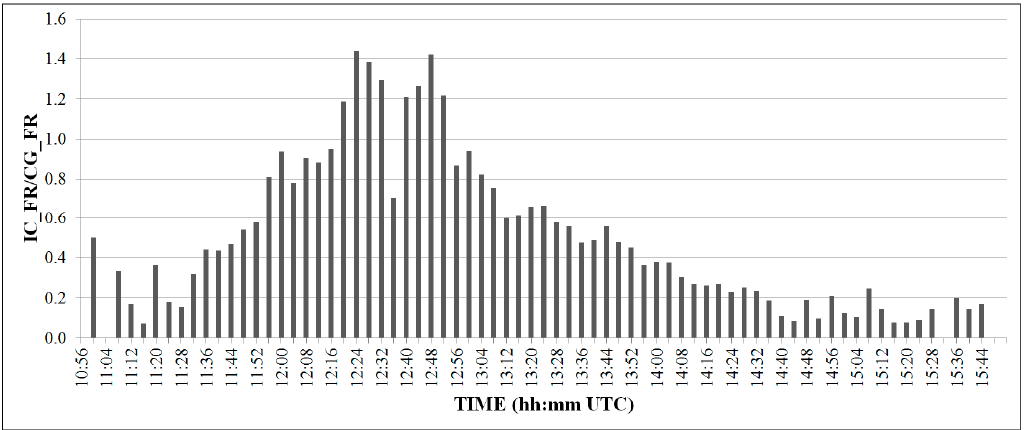
Figure 8. Evolution of the IC-to-CG flash rate (IC_FR/CG_FR) ratio throughout the supercell’s lifecycle.